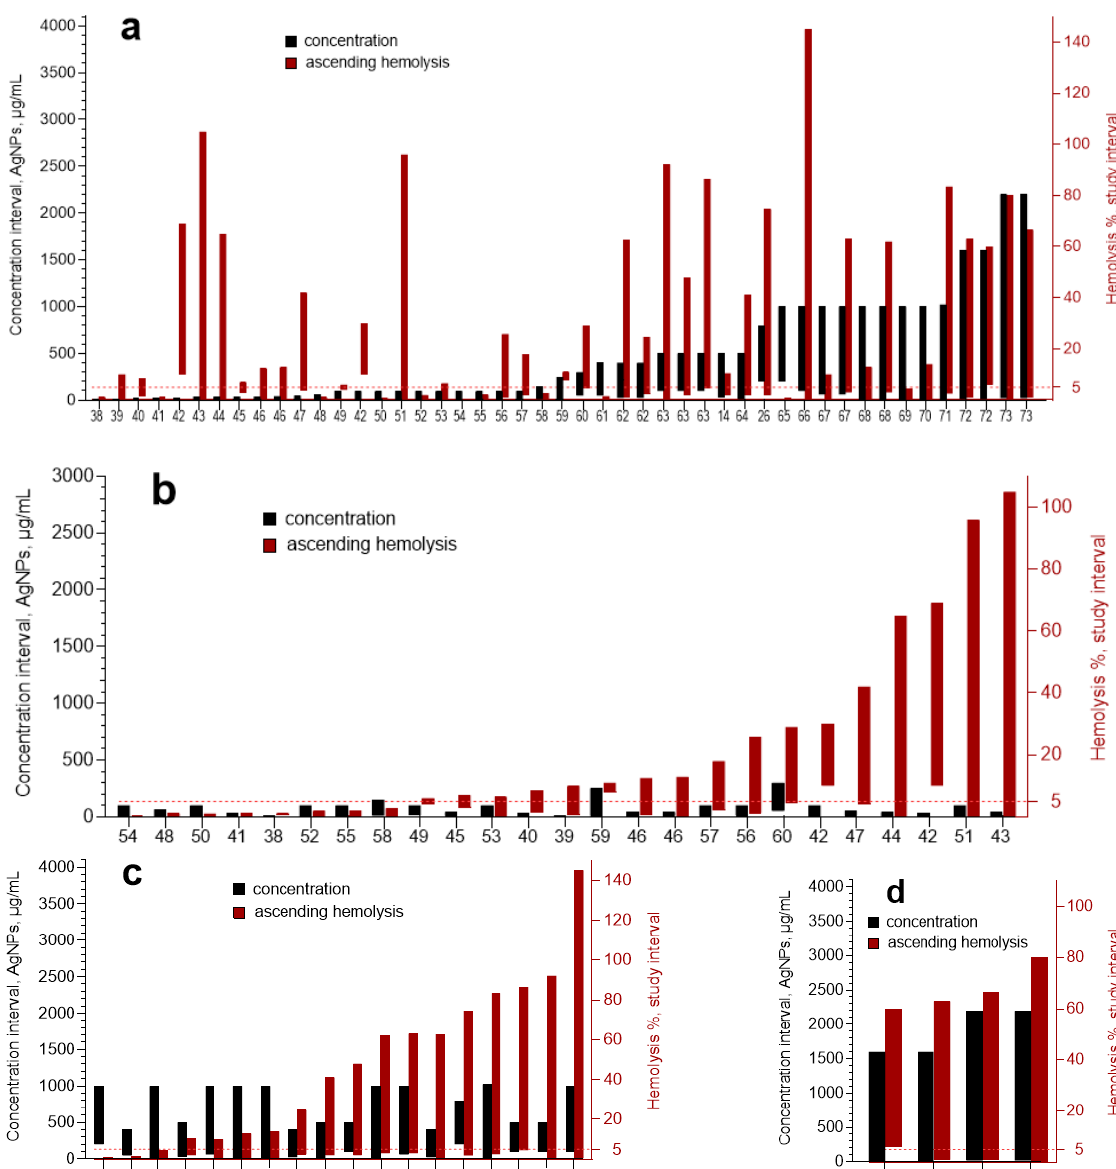
Figure 5. Hemolysis percentage range (red columns) and corresponding interval of AgNPs concen- trations (black columns). General view for 47 AgNPs formulations ordered in accordance with the increase in the maximum concentration of AgNPs ( a ). Three segments of Figure 5a ordered according to maximum hemolysis: 25 formulations studied up to 250 µg/mL ( b ), 18 formulations studied up to 1000 µg/mL ( c ), and 4 formulations studied up to 3000 µg/mL ( d ). References of cited publications are indicated on the abscissa. Adapted from Refs. [38–73]. Table 1. Publications with data excluded from the meta-analysis.